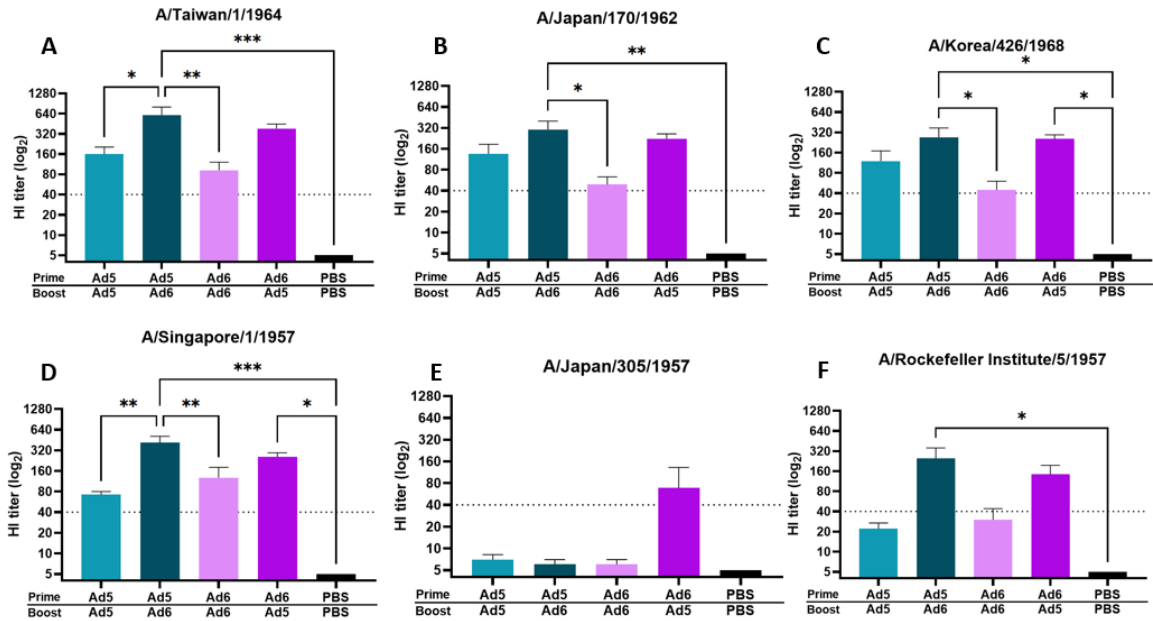
Figure 3. Hemagglutinin inhibition (HI) titers after boost vaccination with homologous or heterol- ogous vaccine regimen. BALB/c mice ( n = 5) were immunized with 10 10 vp of Ad5-H2-Con or Ad6-H2-Con and boosted with their homologous or heterologous adenovirus serotype. HI titers against Taiwan/64 ( A ), Japan/62 ( B ), Korea/68 ( C ), Singapore/57 ( D ), Japan/57 ( E ), and RI/57 ( F ) after homologous or heterologous boosting are shown. Data are represented as the mean HI titer with standard error (SEM). The dotted line indicates a protective titer of ≥ 1:40 ( n = 5; one-way ANOVA with Tukey multiple comparison; * p < 0.05, ** p < 0.01, *** p < 0.005).